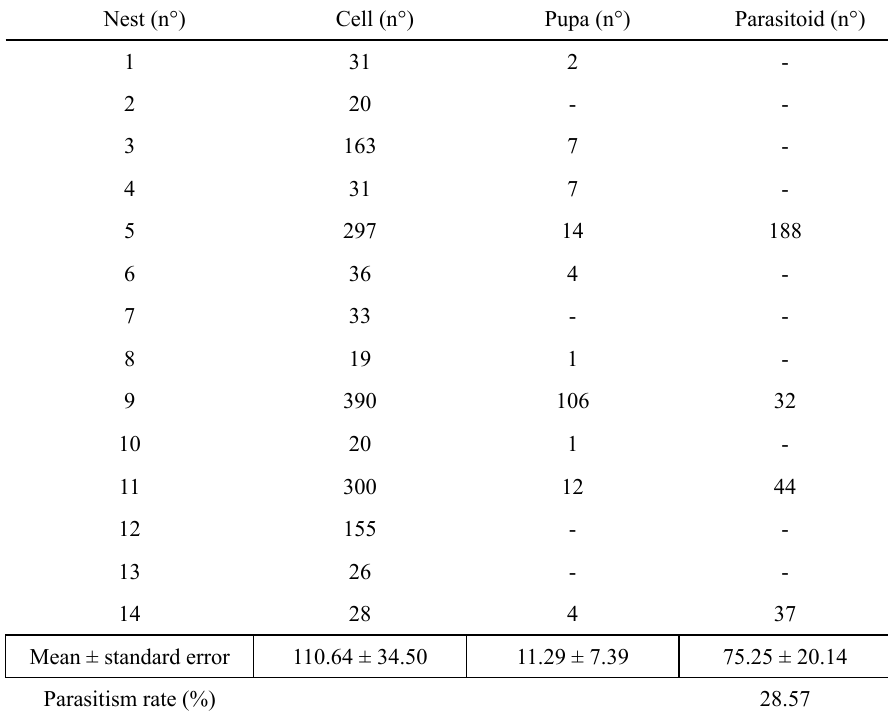
Table 1 . Number of cells and pupae of the nests of Polistes versicolor collected, number of Elasmus polistis parasitoids emerged and percentage of parasitized